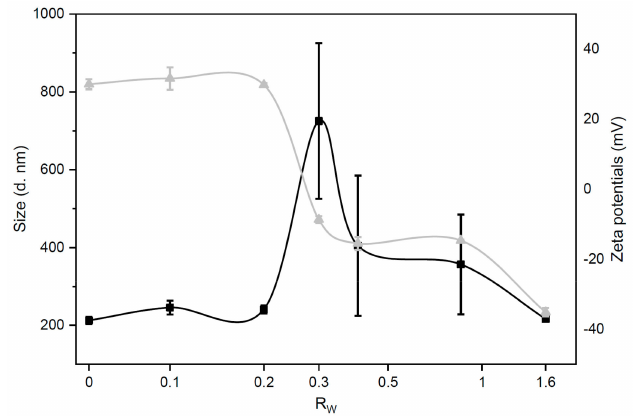
Figure 1. Size (black squares) and zeta-potential (grey triangles) of grapholipoplexes as a function of the DNA / graphene oxide nanoflakes with cationic lipids (GOCL) weight ratio, R W . Grapholipoplexes exhibit typical charge inversion and “re-entrant condensation”. At the iso-electric point (R W = 0.3), grapholipoplexes are neutrally charged and large in size (~800 nm). This is due to short-range van der Waals attraction that prevails over electrostatic repulsion between positively charged GOCL nanoparticles (NPs) and negatively charged DNA. On both sides of the evolution profile, grapholipoplexes are small-sized (~200 nm), with surface charge dominated by excess DNA (R W > 0.3) or excess cationic lipid (R W <